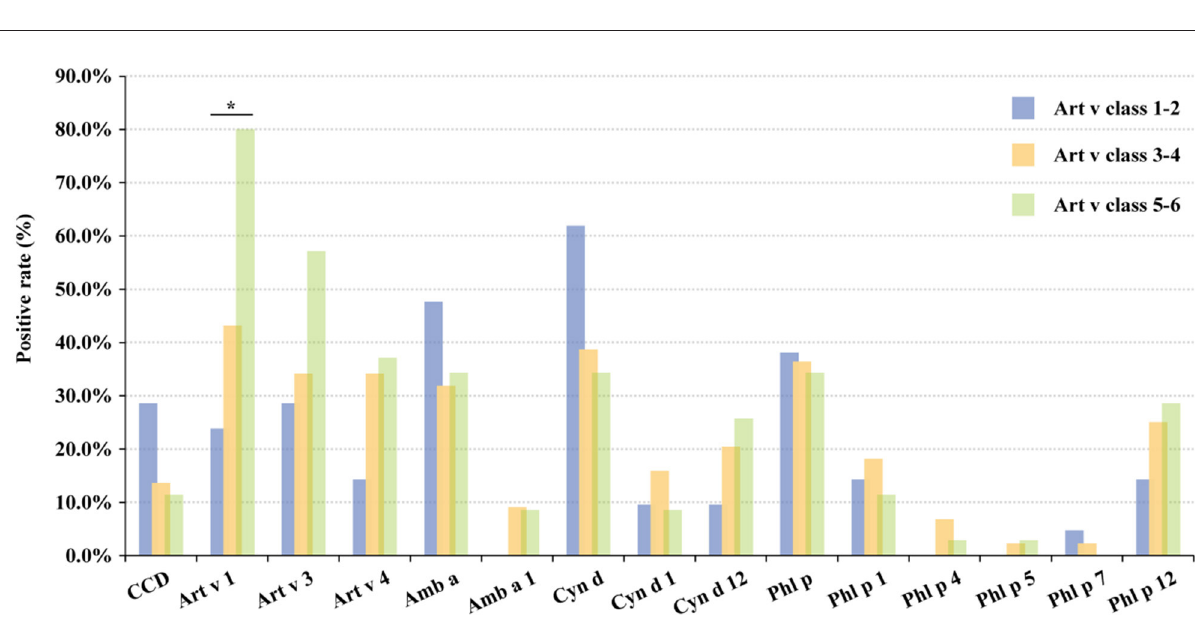
FIGURE 5 | The positive rate of grass pollen allergens in different sIgE levels. The classifications are defined as follows: Class 0, < 0.35 kU/L; Class 1, 0.35–0.70 kU/L; Class 2: 0.70–3.50 kU/L; Class 3: 3.50–17.50 kU/L; Class 4: 17.50–50.00 kU/L; Class 5: 50.00–100.00 kU/L and Class 6: ≥ 100.00 kU/L. *, P < 0.05. CCD, cross-reactive carbohydrate determinants; CRD, component-resolved diagnosis; sIgE, specific IgE; AIR-SKLRD, Allergy Information Repository of State Key Laboratory of Respiratory Disease; Art v, Artemisia vulgaris; Amb a, Ambrosia artemisiifolia; Cyn d, Cynodon dactylon; Phl p, Phleum pratense; AIC, Akaike Information Criterion; BIC, Bayesian Information Criterion; r s , Spearman’s correlation